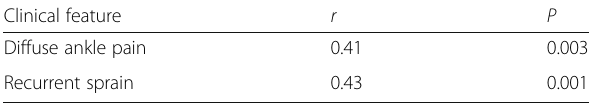
Table 4 Types of surgically proven ligamentous injury Ligamentous tear Complete ATFL